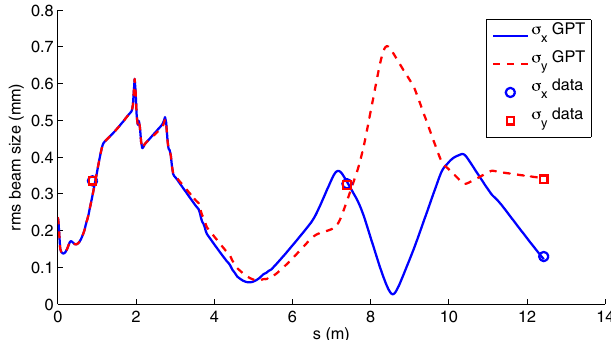
FIG. 11. Comparison of simulated and measured rms spot sizes along the beam line.